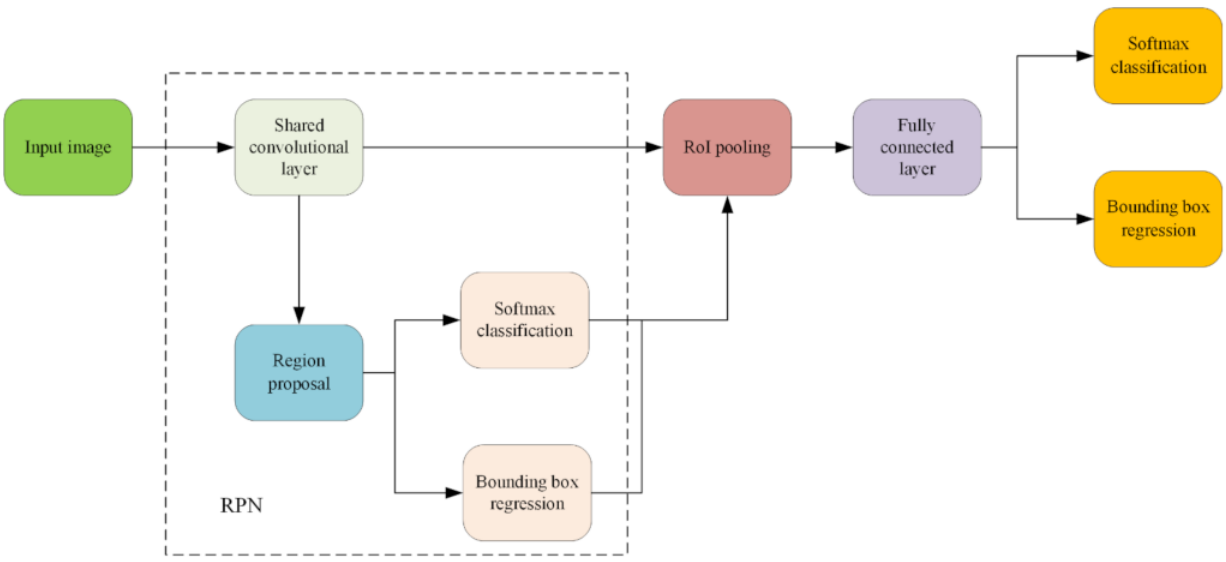
Figure 5. Basic network framework of the Faster